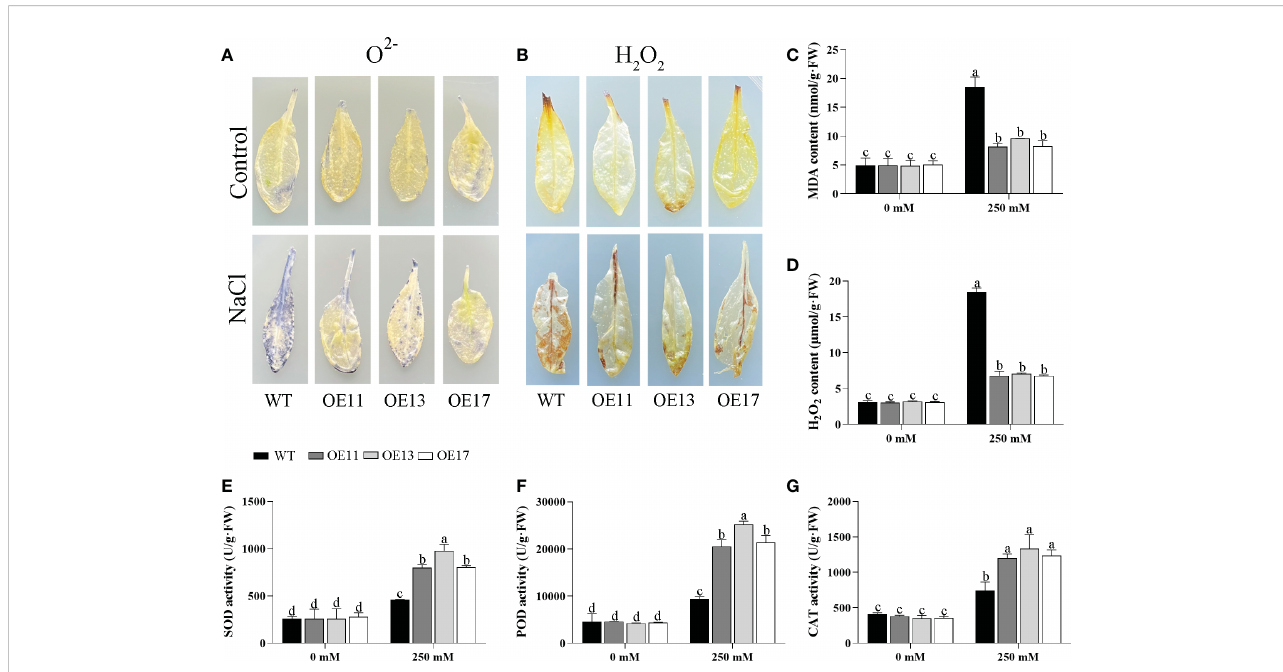
FIGURE 10 Changes in ROS accumulation and antioxidant enzyme activity in CeqHAK11 transgenic lines and WT plants under salt treatment. (A, B) O 2- and H 2 O 2 in the CeqHAK11 transgenic lines and WT plants were detected by DAB and NBT staining. (C, D, E, G) MDA, H 2 O 2 , SOD, POD and CAT content were measured in WT and transgenic plants after salt treatment. All Arabidopsis seedlings were treated with 250 mM NaCl for 10 days. The signi fi cant differences identi fi ed using Duncan ’ s Multiple Range Test ( p <0.05) were denoted by different lowercase letters on the top of bars.